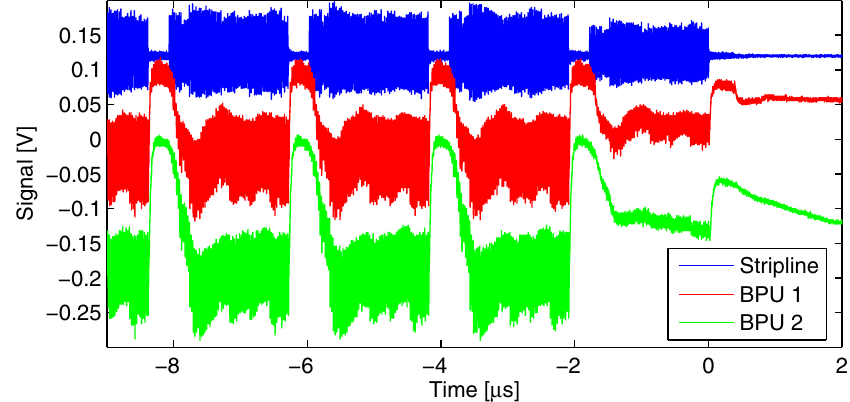
FIG. 4. (Color) Measured signals of the stripline electrode and the button pickups #1 and #2 during the passage of the nominal LHC beam. The last 4 turns before extraction from the PS are shown, the gap between successive recurrences of the same group of 72 bunches is 320 ns. The traces have been stacked vertically for